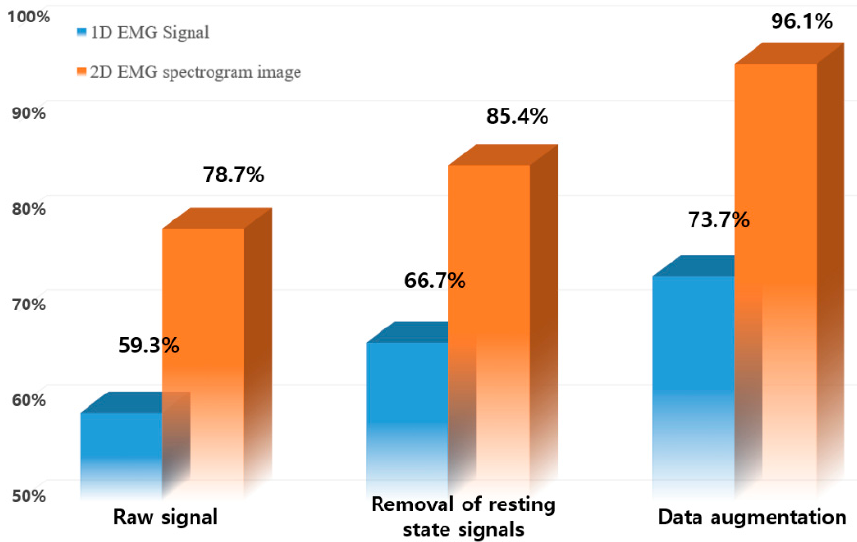
Figure 13. Identification performance based on preprocessing.